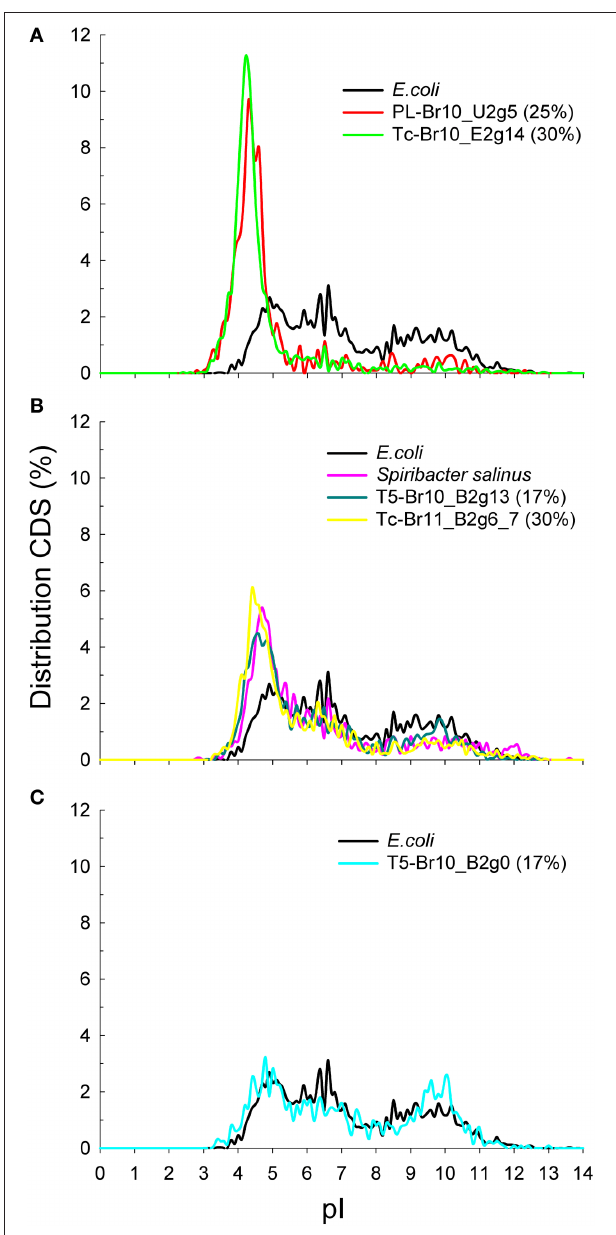
FIGURE 3 | Predicted isoelectric points (pI) for the coding sequences (CDS) of a selection of draft genomes and complete reference genomes indicative for different strategies of osmotic adaptation. (A) archaeal “salt-in”: all archaeal draft genomes had a similar pI-profile, only one Nanohaloarchaea - and one Natrialbaceae -related draft genome are shown here; (B) bacterial “salt-in”; (C) “salt-out.” The salinities of the brines from which the draft genomes were reconstructed are depicted in between brackets (in